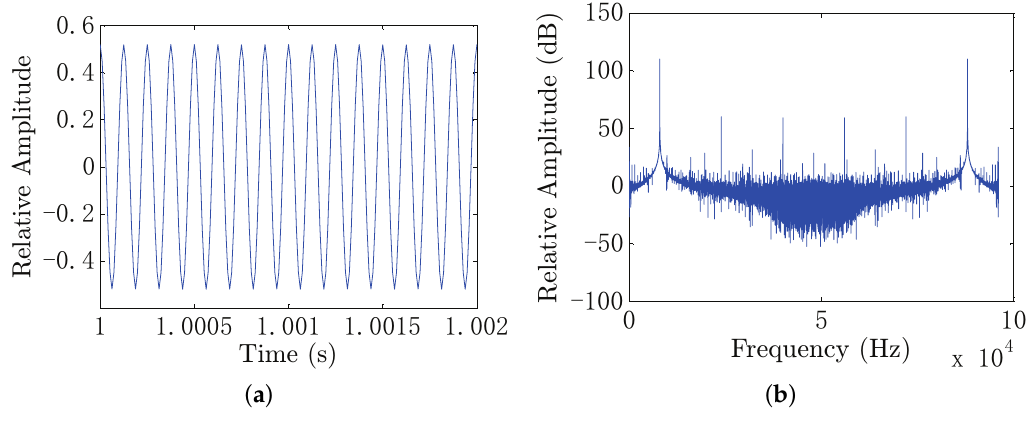
Figure 15. ( a ) The measured voltage in the time domain; ( b ) the frequency spectrum of the measured voltage.